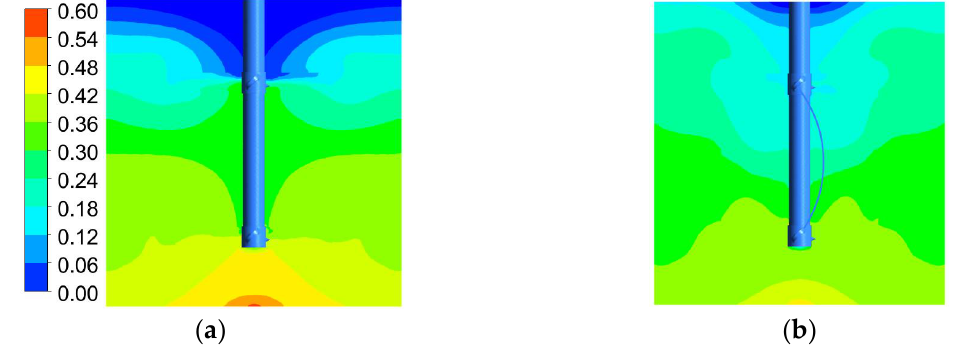
Figure 5. Contour plots of solid distribution for different impeller types. ( a ) DTBI; ( b ) DRFTBI. (Rotational speed: 120 rpm; solid loading: 30%; connection strap length: 1.2 H S ; plane: X = 0.)